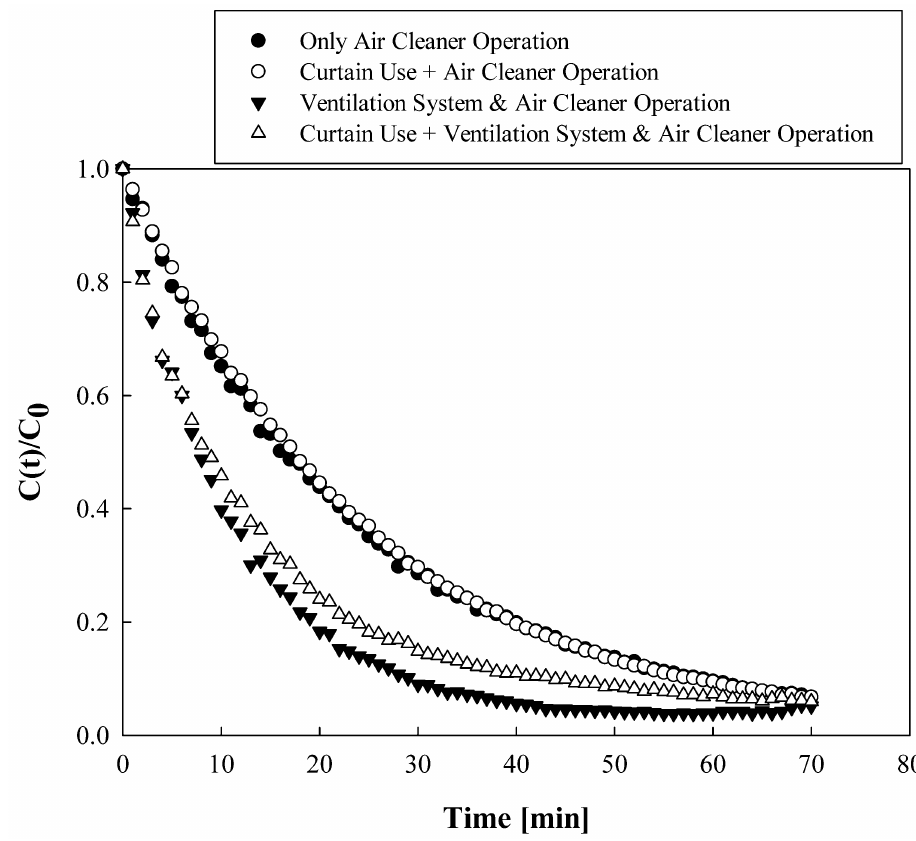
Figure 2. Experimental results of the particle number concentration over time.